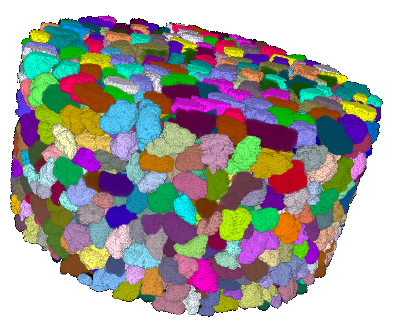
Figure 5. Comparison between the sample (red) and the aver- age grain (blue) volumetric strains (the region represents the er- ror margin of the grain volumetric strain) along with the sample porosity